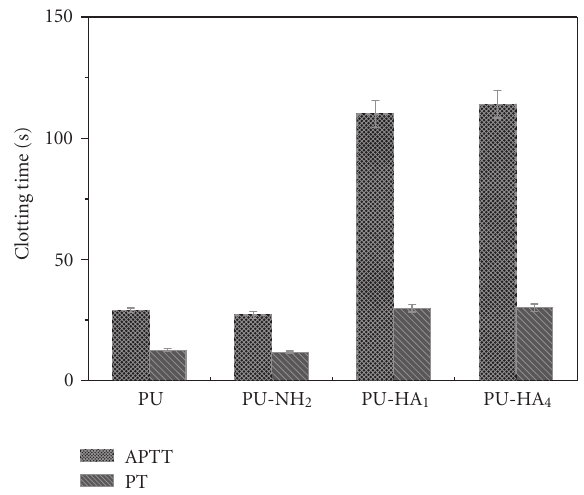
Figure 7: Comparison of anticoagulant properties of di ff erent films: APTT and PT ( n = 3, mean ±